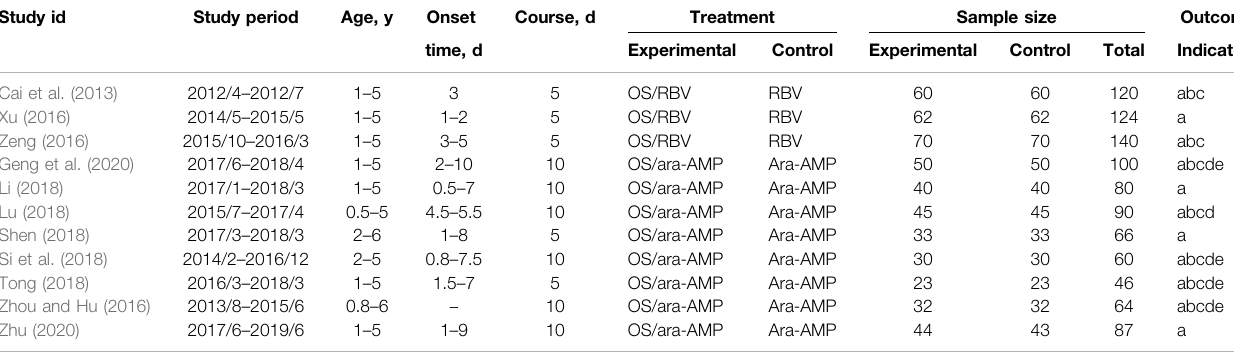
TABLE 1 | Characteristics of the studies included in the meta-analysis.